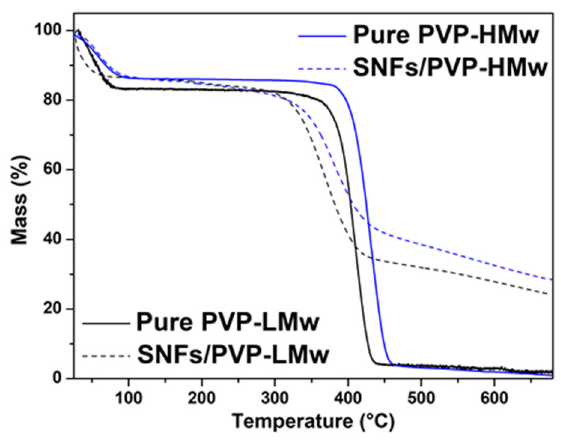
Figure 2. TGA curves of SNFs/PVP-LMw and SNFs/PVP-HMw.